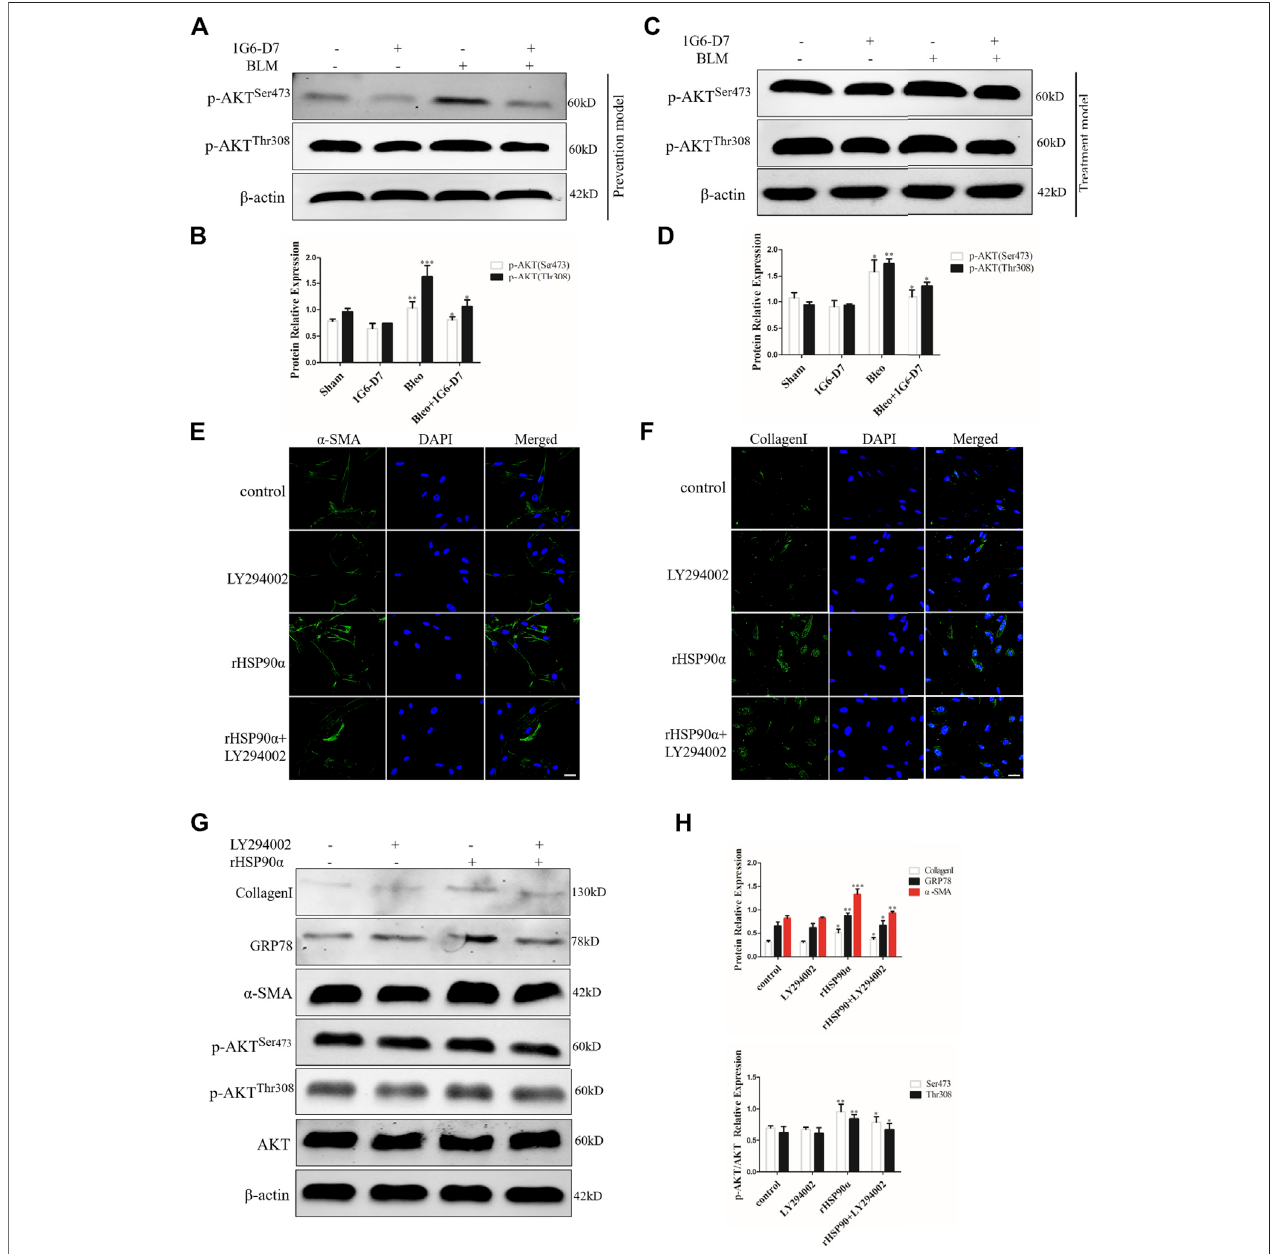
FIGURE8| PI3K/AKTsignaling pathway isinvolved inERstressinduced byeHSP90 α .The expression of p -AKT Ser473 and p -AKT Thr308 wasmeasured bywestern blot in the prophylactical model (A,B) and in the therapeutical model (C,D) . Immuno fl uorescence staining showed that α -SMA and CollagenI in IMR90 cells pre-treated with or without LY294002 (10 μ M) followed by rHSP90 α stimuli (E,F) . Scale bar (cid:1) 50 μ m. (G,H) . Western blot analysis of the expression of CollagenI, GRP78, α -SMA, p -AKT Ser473 , p -AKT Thr308 and AKT. β -actin was used as an internal control. * p < 0.05, ** p < 0.01, *** p < 0.001.